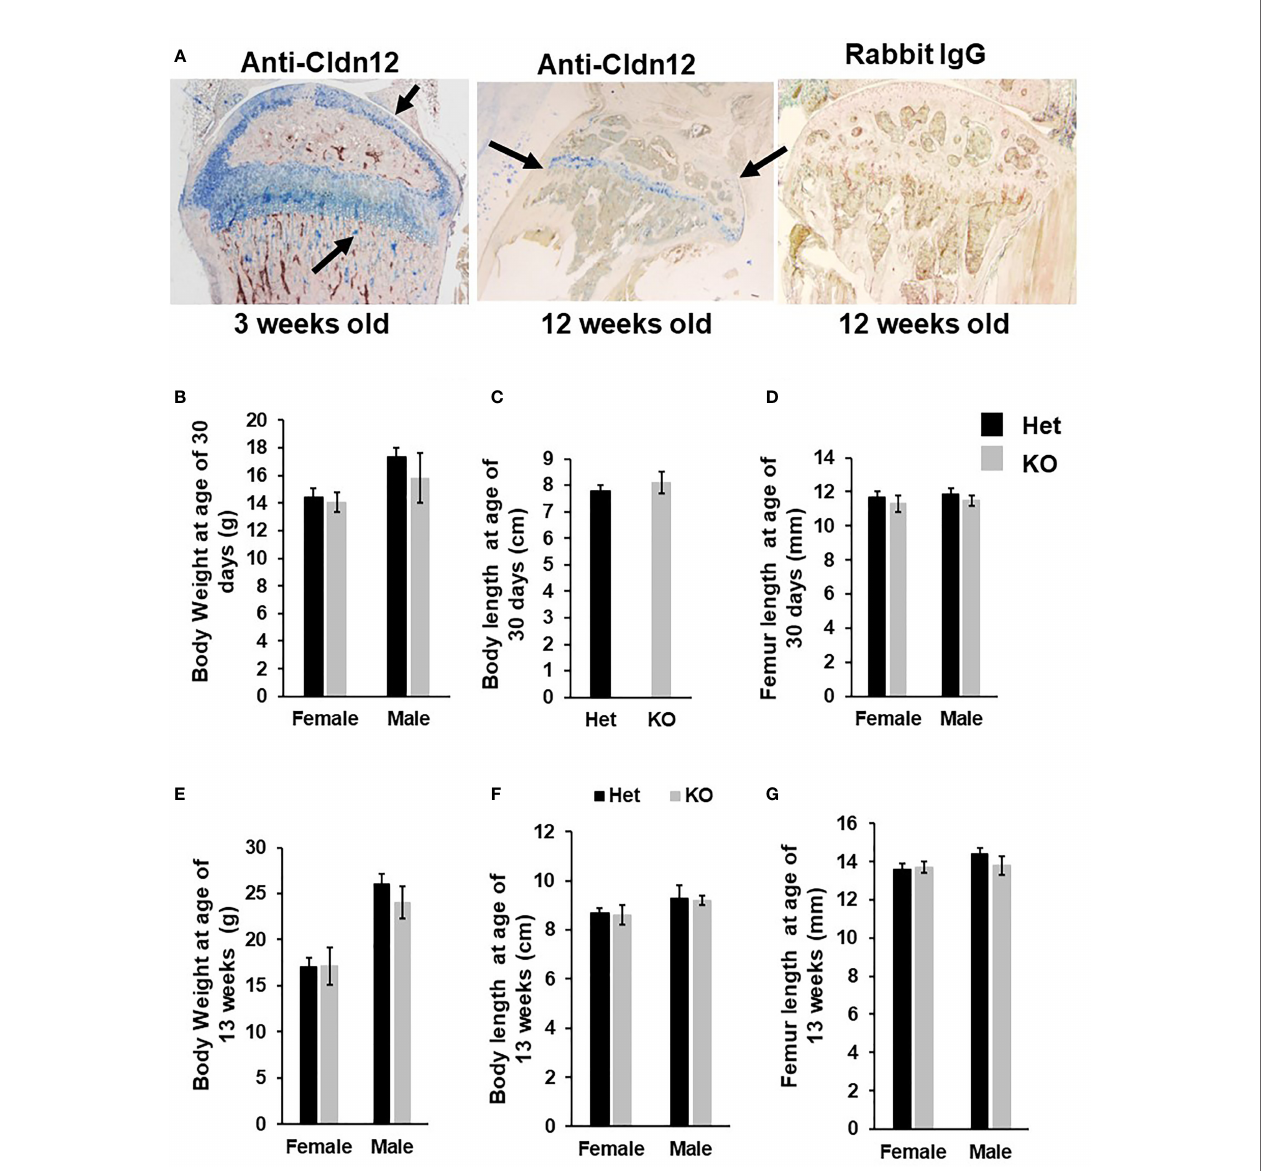
FIGURE 1 | Mice with disruption of Cldn12 exhibit no changes in body weight, body length and femur length at ages of 30 days and 13 weeks. (A) Expression of CLDN12 in chondrocytes and osteoblasts in the tibia of 3- and 12-weeks old mice, detected by immunohistochemistry. Arrows indicate blue staining in CLDN12 positive cells. (B-D) Body weight, body length, and femur length of the Cldn12 knockout (KO) and the control heterozygous littermates at 30 days of age, respectively. (E-G) Body weight, body length, and femur length of the Cldn12 knockout (KO) and the control littermates at 13 weeks of age,